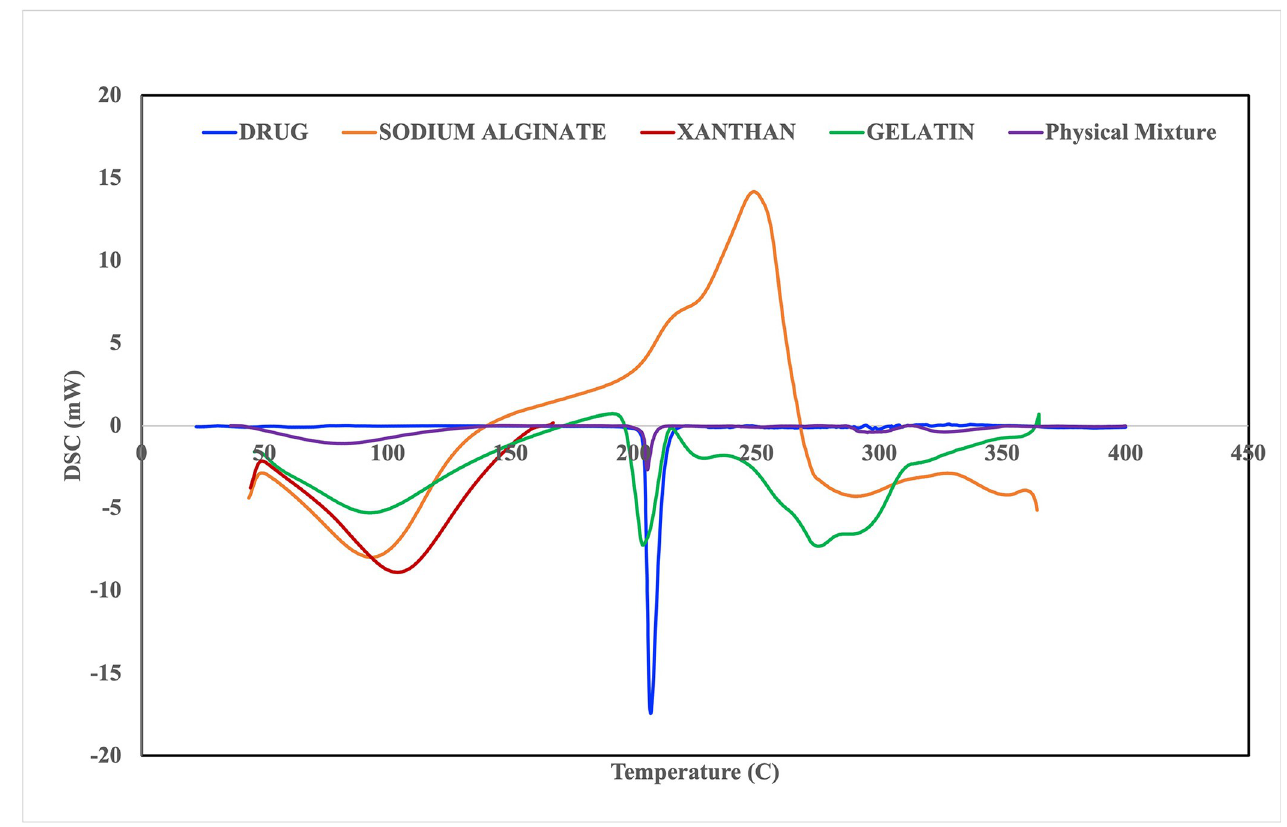
Fig 1. DSC thermograms of drug and excipients.